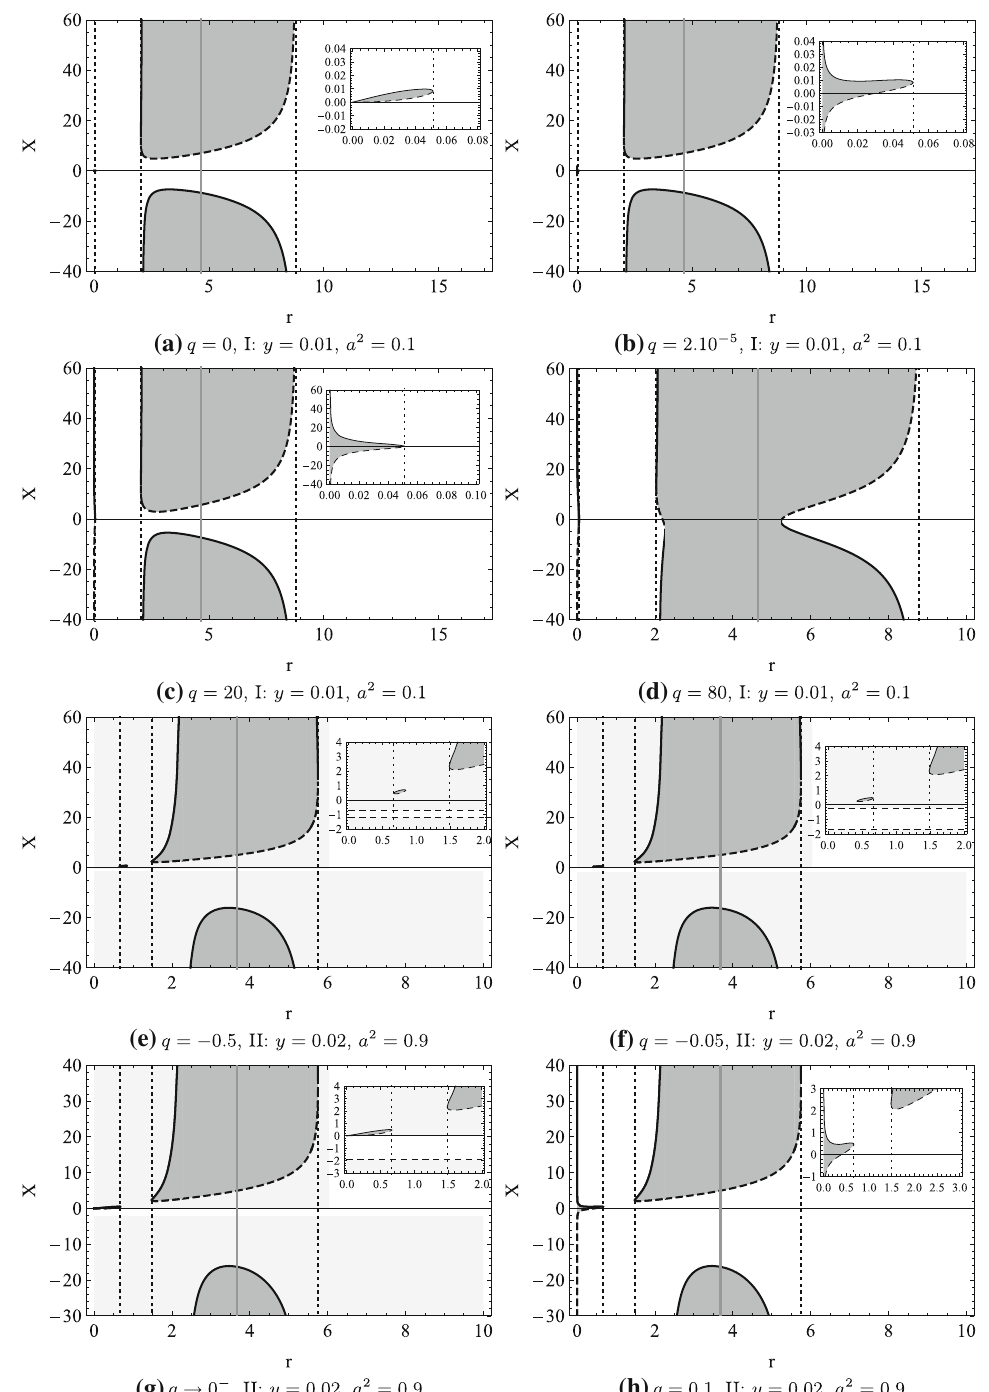
Fig. 10 Different types of behavior of the potentials X + ( r ; q , a , y ) graphs X ± ( r ; q , a , y ) lie entirely in forbidden region. The behavior (full curve), and X − ( r ; q , a , y ) (dashed curve), with spacetime param- of these functions in other cases differing by values a , y with q < 0 is qualitatively the same. γ – δ describes the case y > 1 / a 2 , q < 0 . eters chosen successively from regions corresponding to the classes I– The potentials have values in the forbidden region again; for q > 0 the VIII in the a 2 – y plane, and some representative values of parameter q behavior of the potentials qualitatively corresponds to class VII. In the divided by the extrema q ( y , a 2 ). Vertical dashed lines demarcate loci classes IVb, VIb, the local minima of the potentials X − ( r ; q , a , y ) of the event horizons, the gray line demarcate the static radius, shad- ing highlights the forbidden region. e – g depict the case q < 0 with (see q , y ) have values X min ( − ) < − a , contrary to cases IVa and VIa, , X θ the limiting values X θ which are not displayed, since there are no other qualitative as horizontal dashed lines. The min ( − ) max ( + )